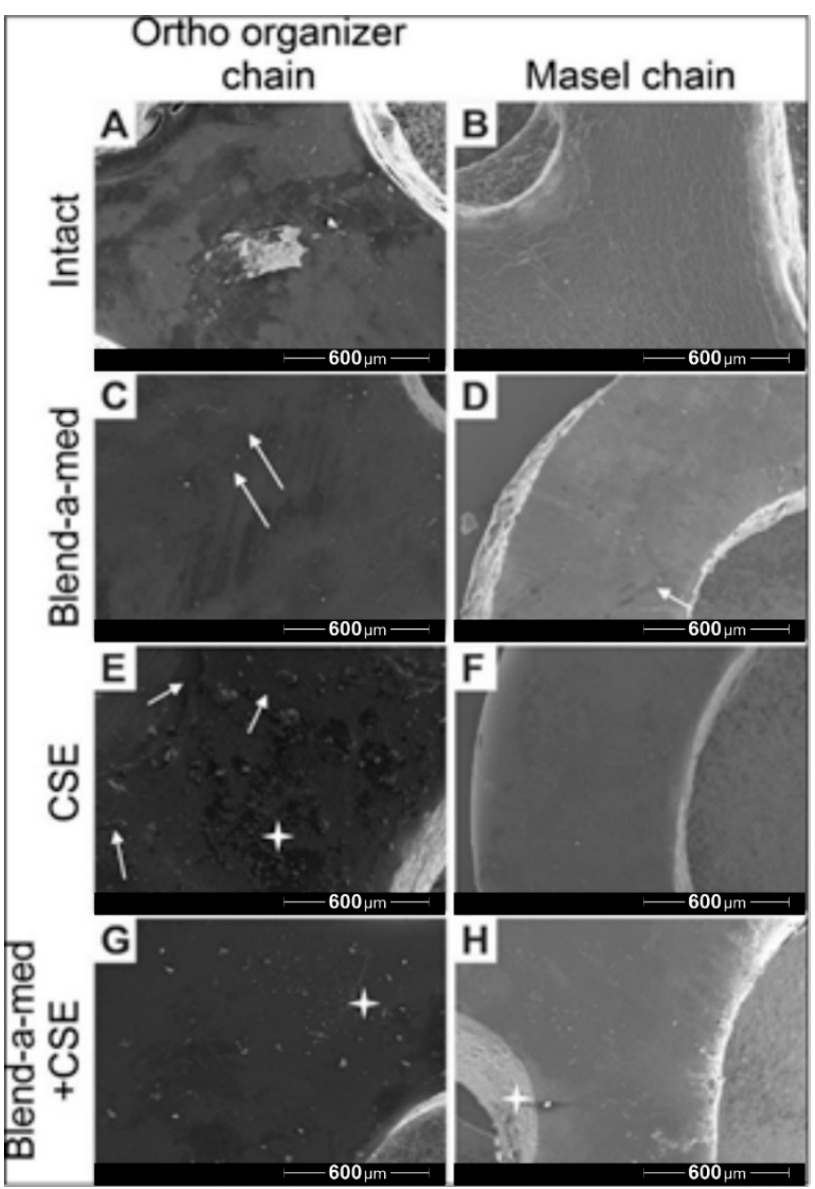
Figure 6. Representative electron microscopy images of ( A , C , E , G ) Ortho Organizer and ( B , D , F , H ) Masel elastic chains after 8 weeks of exposure to ( A , B ) control environment (artificial saliva), ( C , D ) cleaning with Blend-a-med toothpaste, ( E , F ) cigarette smoke as well as ( G , H ) cigarette smoke combined with mechanical cleaning with toothpaste. The white arrows indicate the microlaesions, and a white start highlights particles from smoke exposure. 80× magnification.